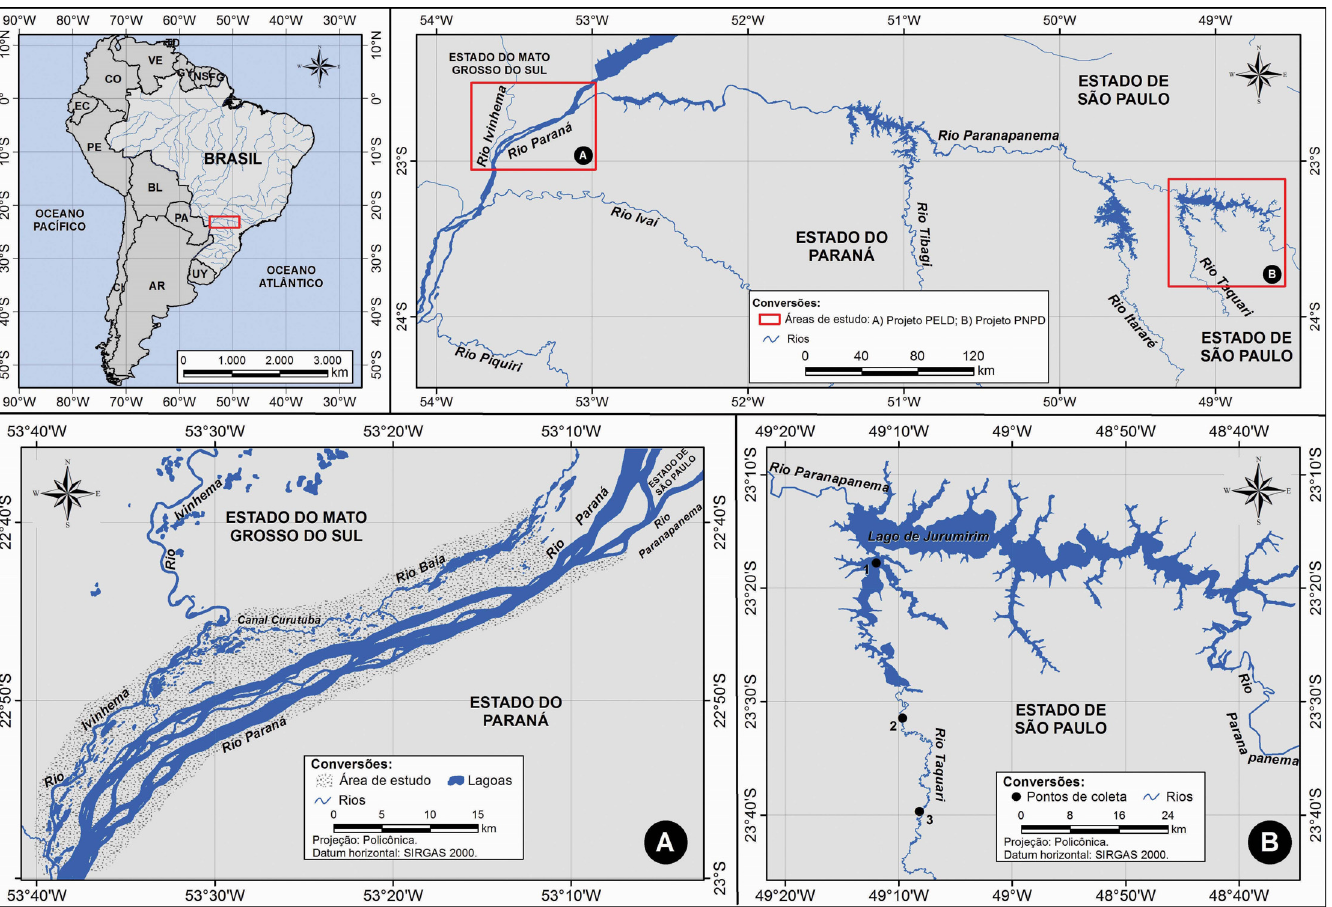
Fig 1. Sampling sites of fish in the Parana´ River and its tributaries between 2012 and 2015. A) Project PELD area with rivers Ivinheima (22˚47’S—53˚32’W), Baia (22˚43’S—53˚17’W) and Parana´ (22˚45’S—53˚15’W) in the flood plain of the upper Parana´ River. B) Sampling sites of Salminus hilarii in the Taquari River: Site 1